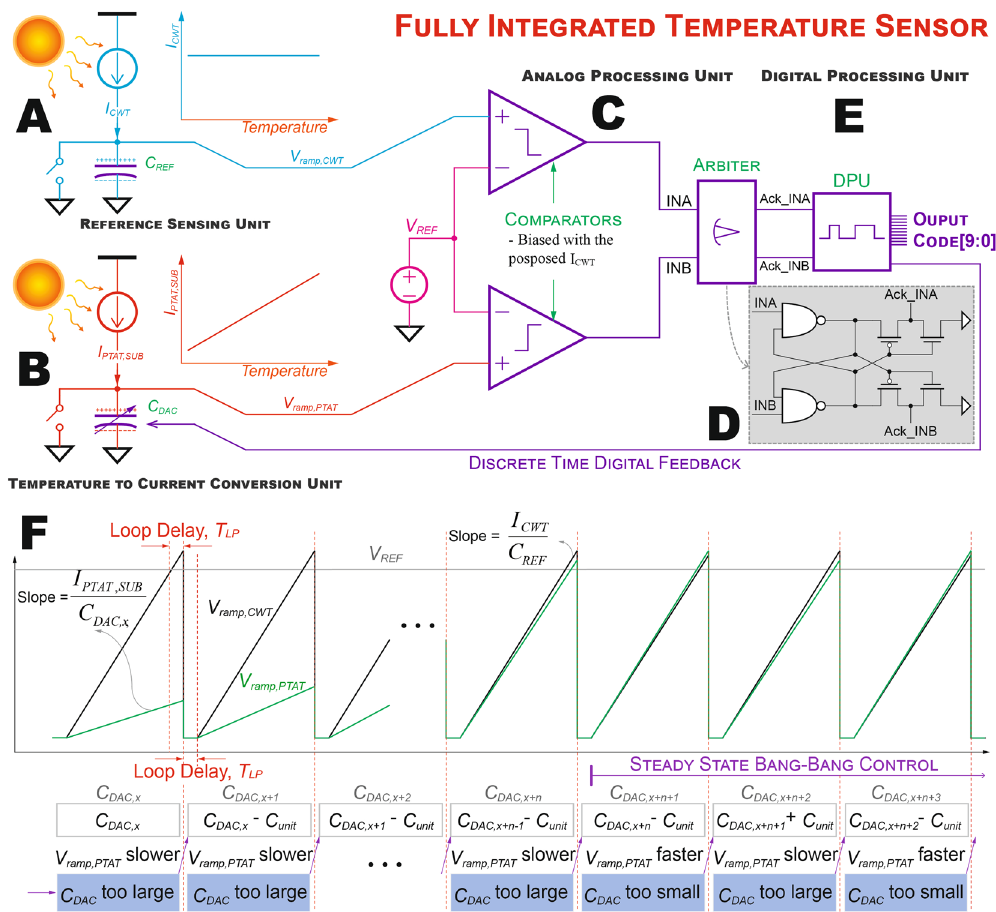
Figure 2. Architecture of the proposed temperature sensor. ( A ) A temperature-stable current source was employed to generate a CWT ramp voltage, V ramp , CWT , by charging capacitor C REF . ( B ) A PTAT current source was employed as the temperature sensing core by converting temperature to a corresponding current and generated a PTAT ramp voltage, V ramp , PTAT , by charging a digitally-controllable bank of capacitors C DAC . ( C ) An analog processing unit consisting of a temperature-stabilized VRG, comparators, and an arbiter was implemented to translate the temperature-encoded analog voltages to digital signals. ( D ) Schematic of the Arbiter. ( E ) A digital processing unit processes the information, controls C DAC , and generates the digital codes corresponding to the ambient temperature. ( F ) An example operation of the DPU illustrates that C DAC was tuned via discrete time digital feedback to match the rising time of V ramp , CWT in